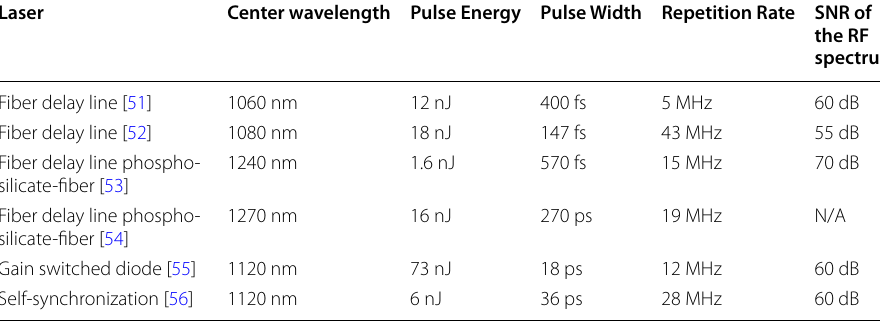
Table 2 Performances of some representative synchronously-pumped Raman fiber